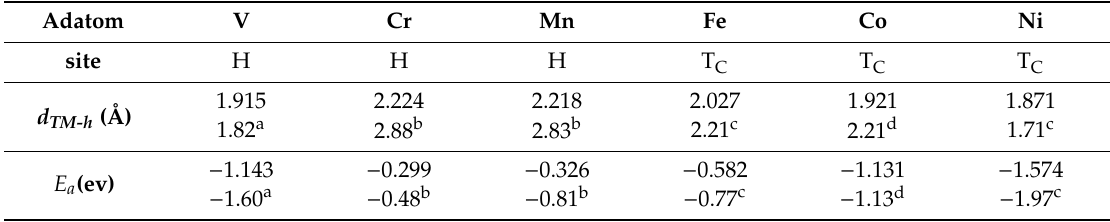
Figure 3. The adsorption energy of TM atoms adsorbed to different sites of single layer BC 2 N. Table 1. The adsorption position, the adsorption energy ( Ea ), the perpendicular distance between TM atoms and monolayer BC 2 N ( d TM-h